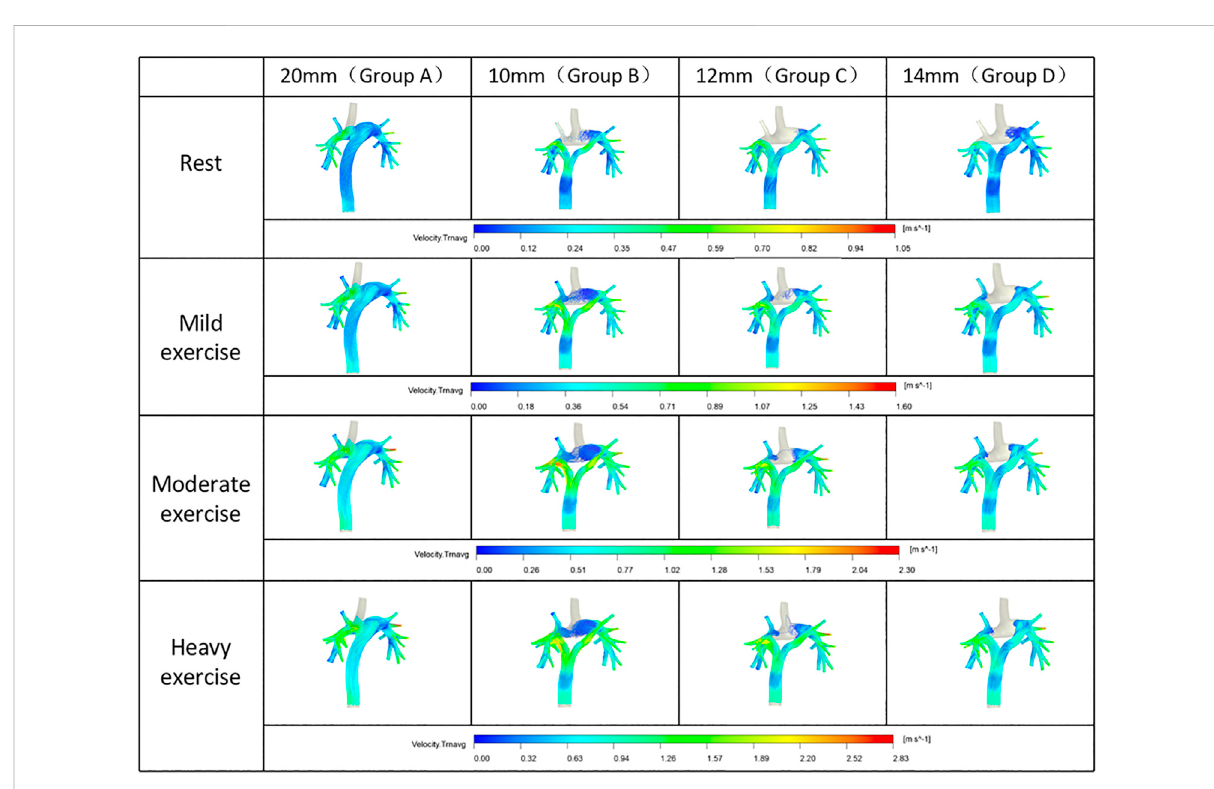
FIGURE 4 Distribution of the inferior vena cava blood fl